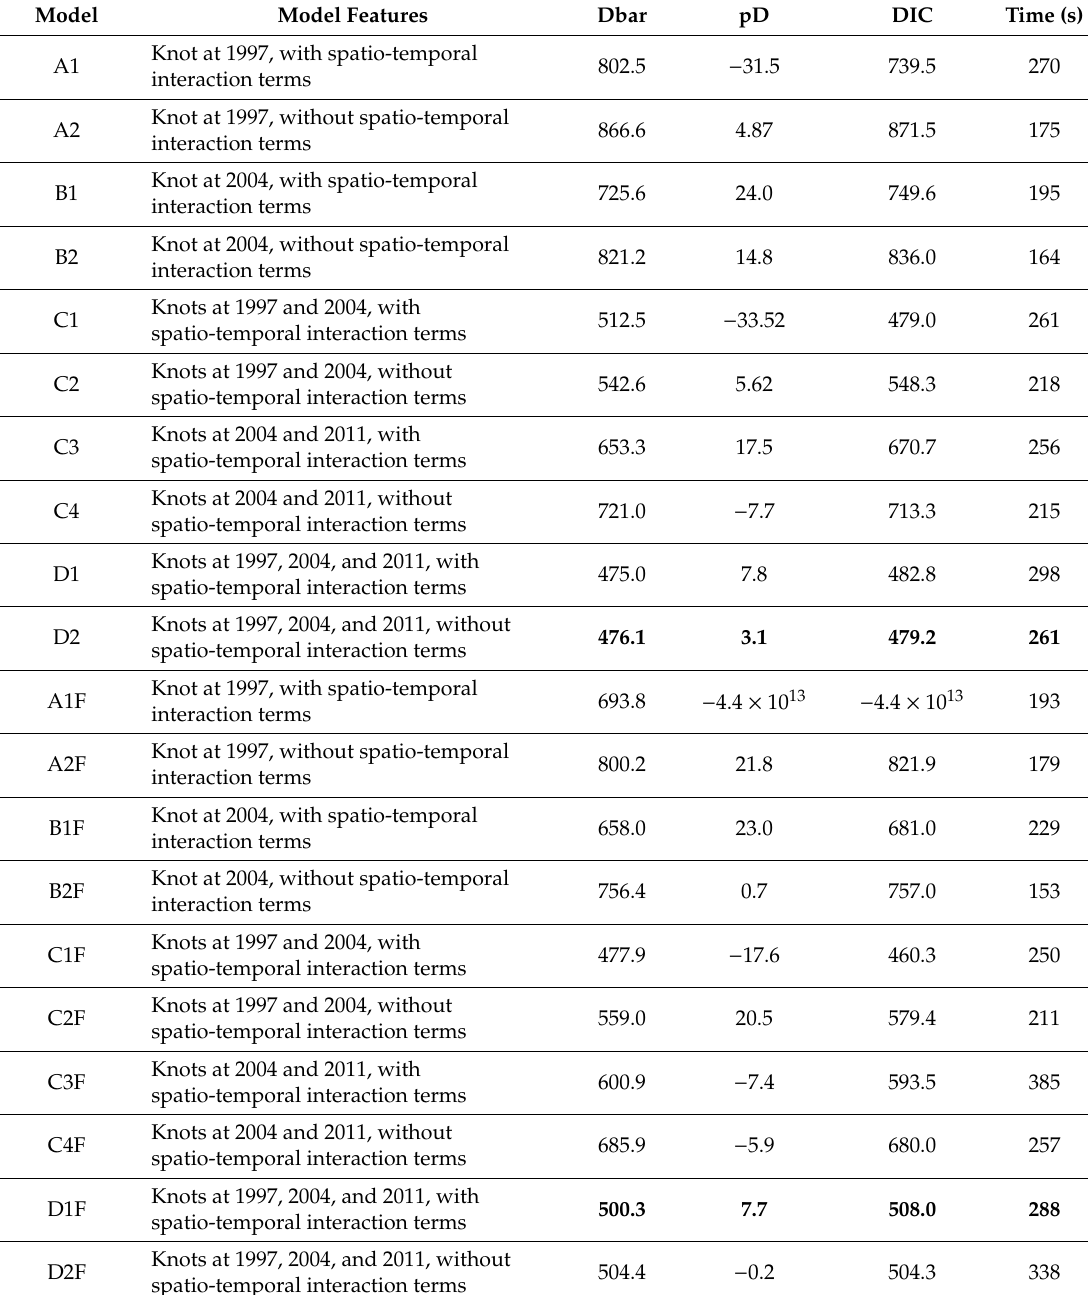
Table A1. Spatio-temporal BYM model